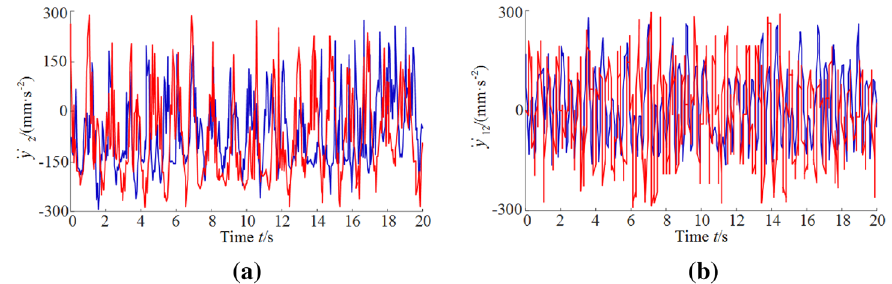
Figure 12. Vibration acceleration of rocker arm ( a ) and walking box ( b ).